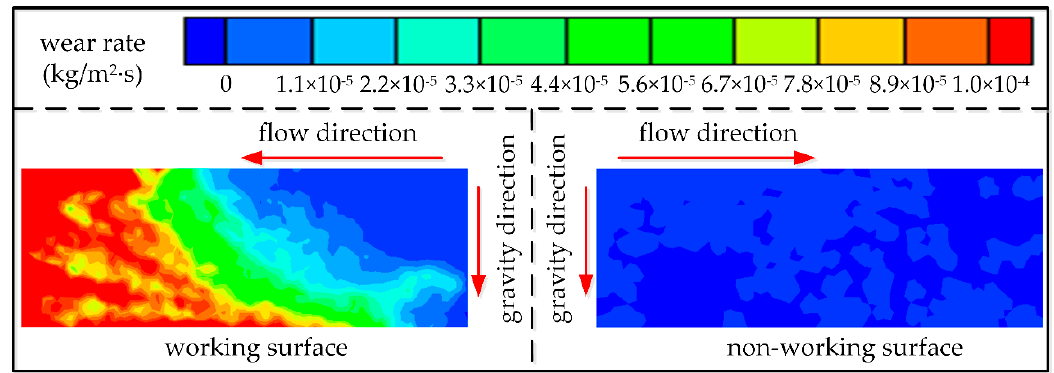
Figure 11. Wear cloud diagram at 600 rpm at 8% particle mass concentration.